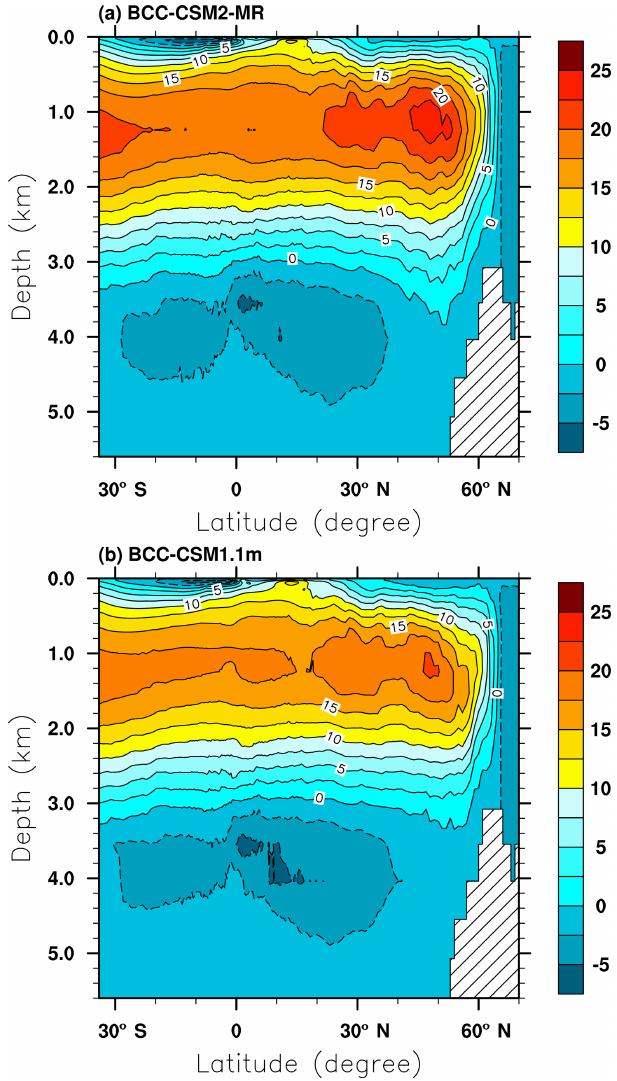
Figure 16. Zonally averaged streamfunction of the Atlantic Merid- ional Overturning Circulation (AMOC) for the period from 1980 to 2005 in BCC-CSM2-MR (a) and BCC-CSM1.1m (b) . (Units: Sv.)